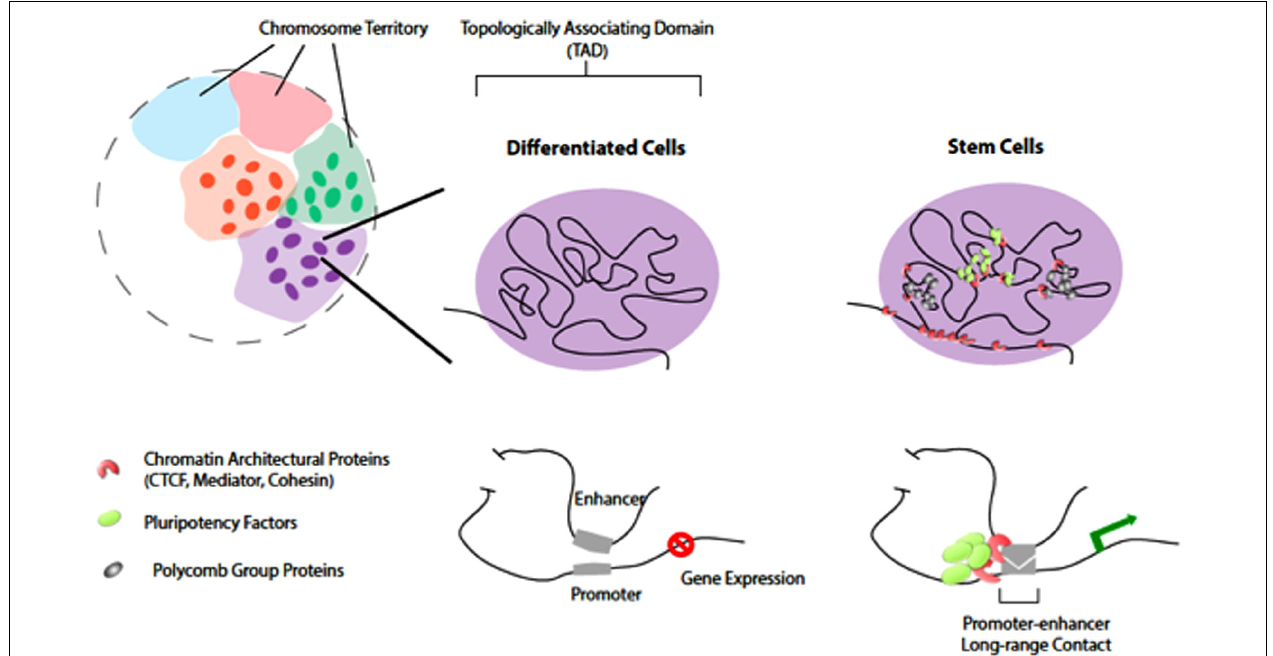
a finer levH pluripotency factors and chromatin architectural proteins organize higher-order chromatin connectivity during reprogramming. Pluripotency factors co-localize and occupy distinct spatial regions from PcG proteins in stem cells. Such chromatin reorganization induced by pluripotency factors is important for cell-specific gene